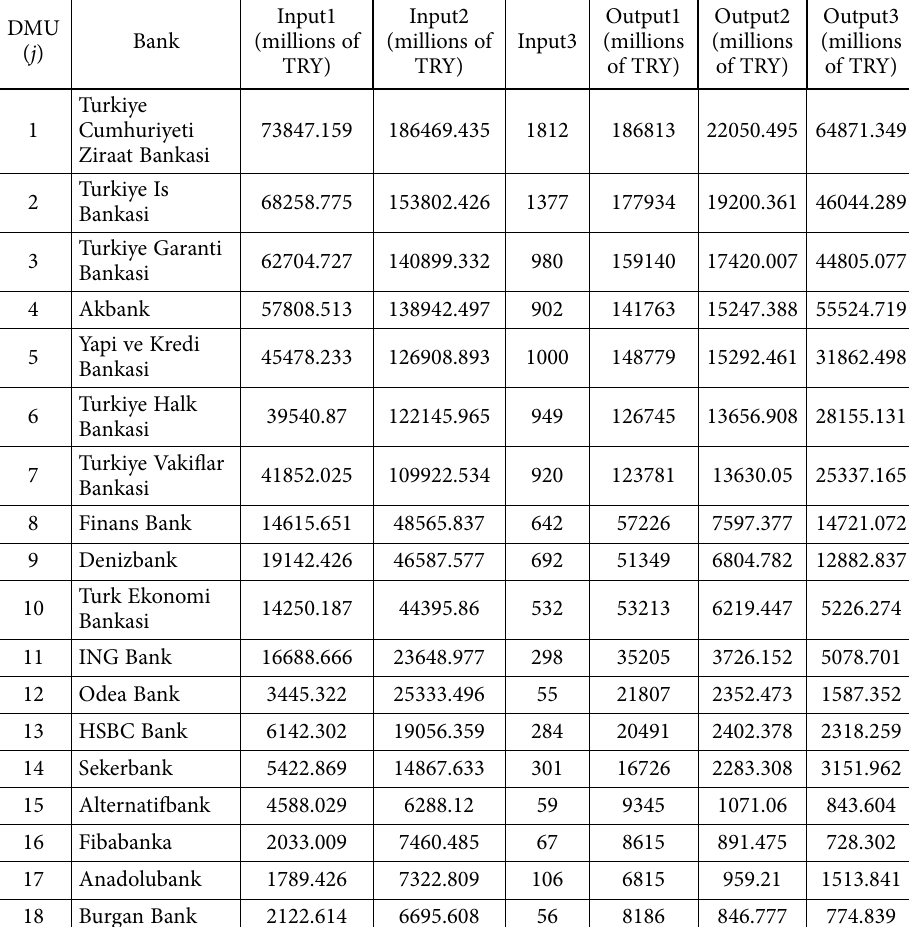
Table 6. Input and output data for deposit banks (source: Türkiye Bankalar Birliği,